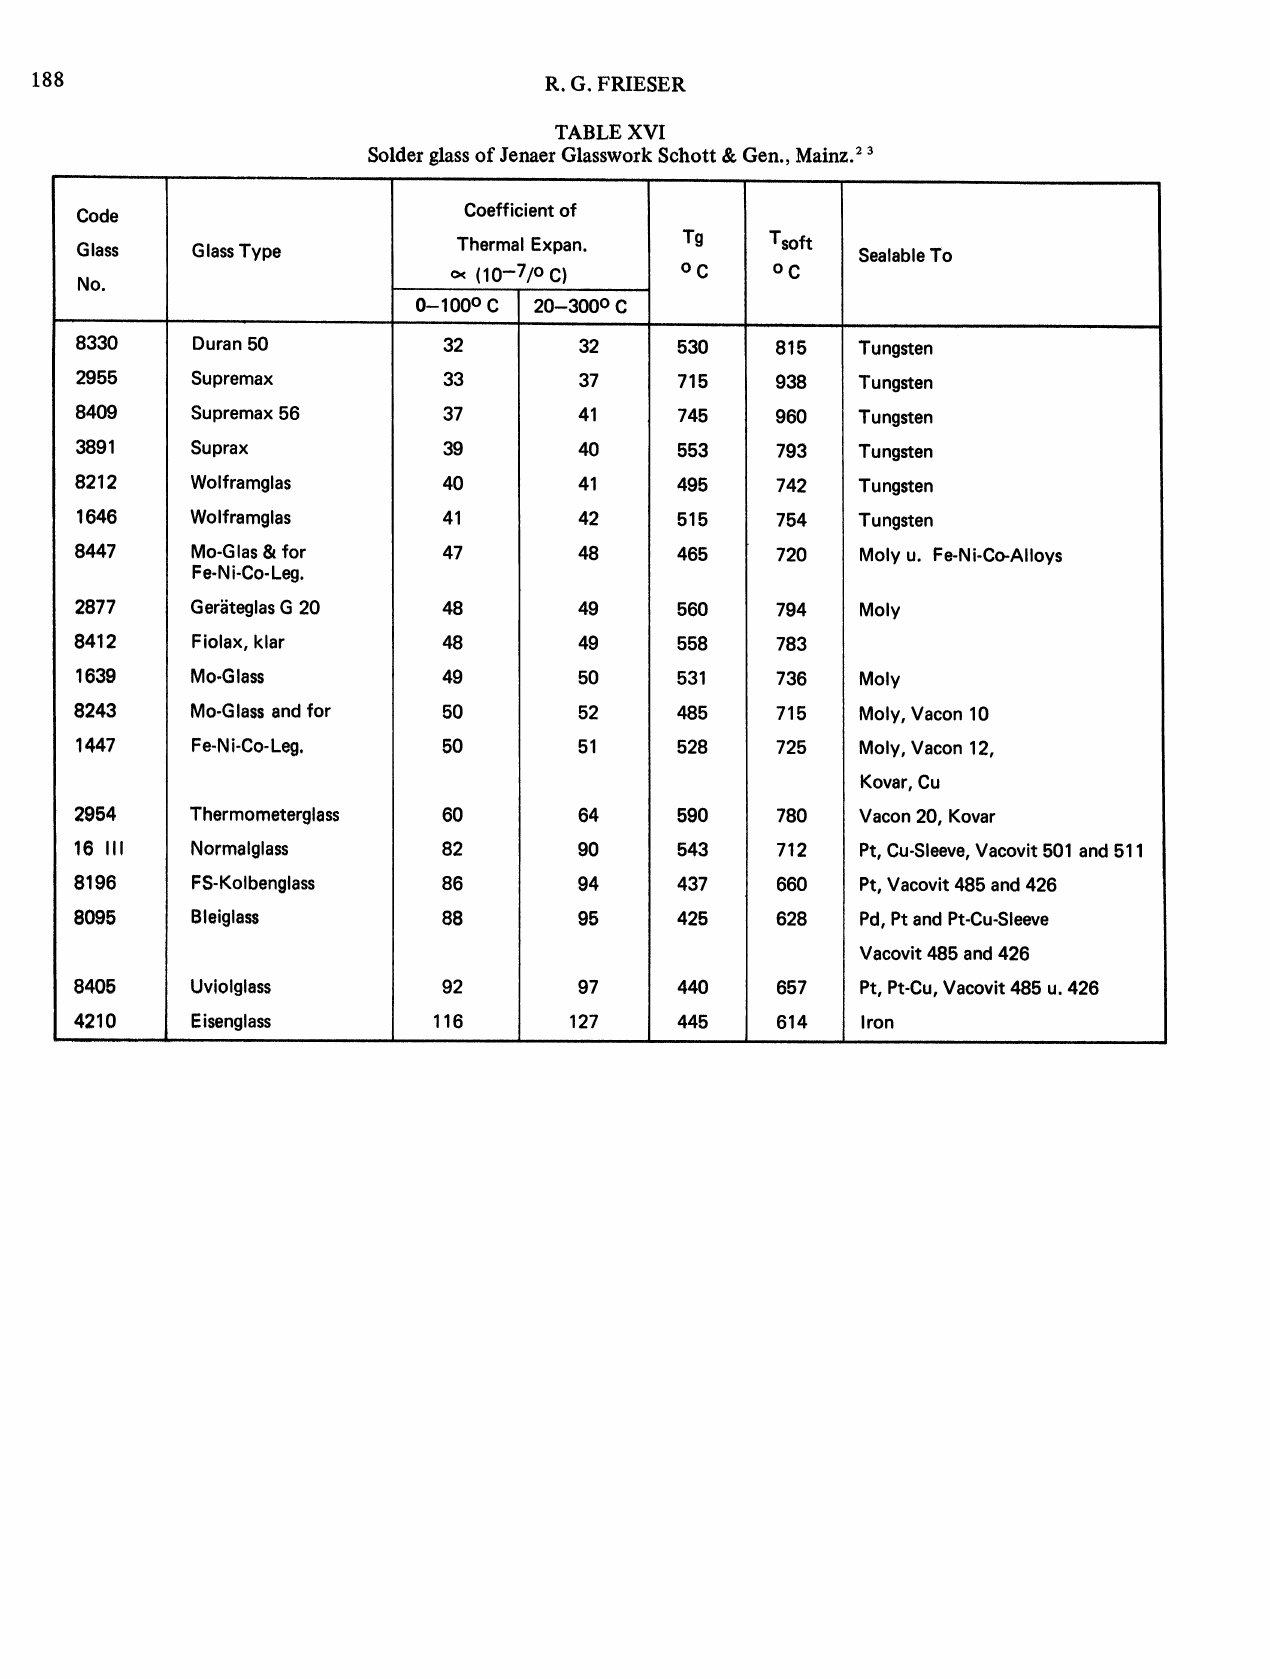
TABLE XVI Solder glass of Jenaer Glasswork Schott & Gen.,